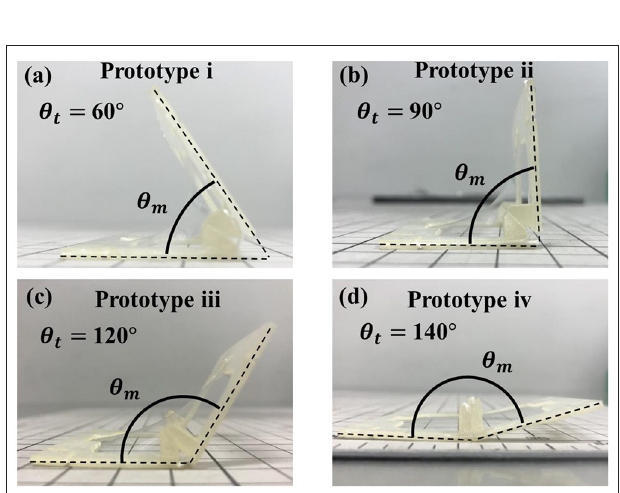
FIGURE 9 | Four prototypes with different target angles θ t to measure self-folding angles θ m . (a) The state of target angle θ t = 60 ◦ . (b) The state of = 140 ◦ . t